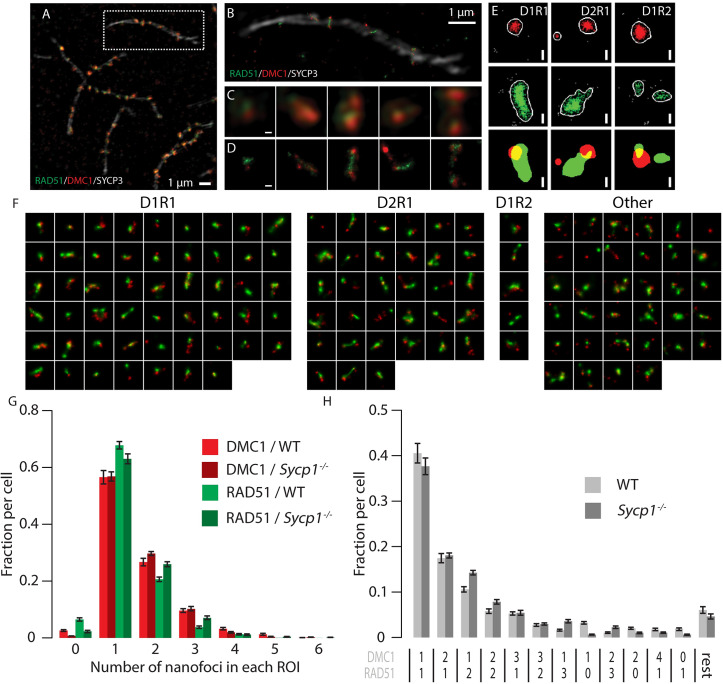
Meiotic DSB foci in super-resolution.A) Cropped region from a SIM image of a spread mouse late zygotene nucleus immunostained with primary antibodies for RAD51, DMC1, and SYCP3, and appropriate secondary antibodies conjugated with Alexa 488 (green), Alexa 647 (red), and Alexa 555 (white), respectively. B) SYCP3 SIM overlayed with RAD51/DMC1 dSTORM images of boxed region in A). C) Close-up of single DSB foci present on the synaptonemal complex shown in A). D) The same foci visualized with dSTORM. E) Single DSB foci of three types (left panels D1R1, middle panels D2R1, right panels D1R2) represented by 2 different visualisation/analysis methods: scatter plot of localisations and merged binary representation of the kernel density estimation. F) Compilation of all ROIs of a single late zygotene nucleus (indicated with an asterisk in S2 Fig). ROIs are sorted by their DxRy configuration, from most frequent to rare configuration. G) Fraction of foci containing the indicated number of RAD51 or DMC1 nanofoci per focus as a percentage of the number of foci per genotype. H) fraction of foci containing the indicated combinations of RAD51 and DMC1 nanofoci per focus as a percentage of the number of foci per genotype. Combinations that represented less than 1% of the foci in both wild type and Sycp1-/- were grouped in the category referred to as rest. Scale bars in C-E represent 100 nm. Error bars represent SEM values. Results of statistical analyses are described in S2 Table.